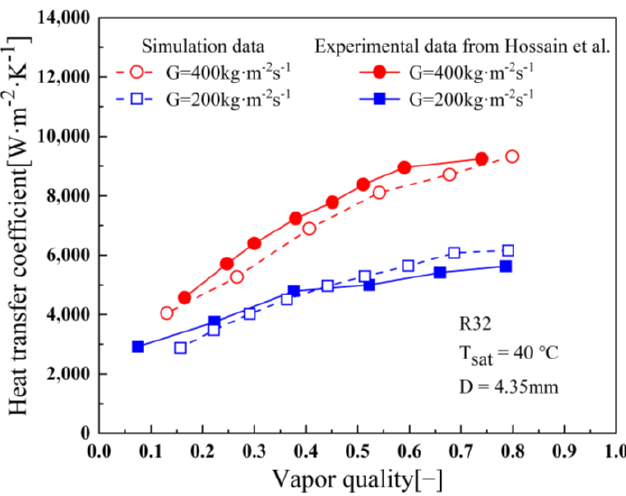
Figure 2. Comparison of simulated data with experimental data from Hossain et al. [37].